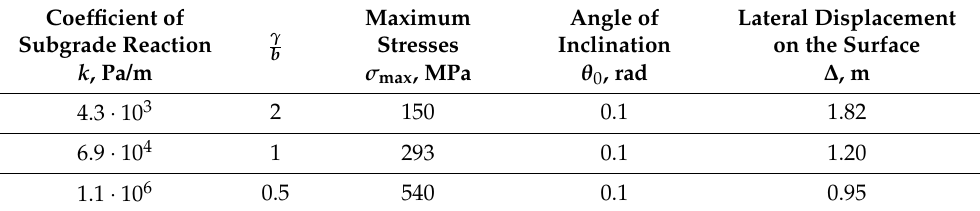
Table 1. The results of the calculation of mechanical